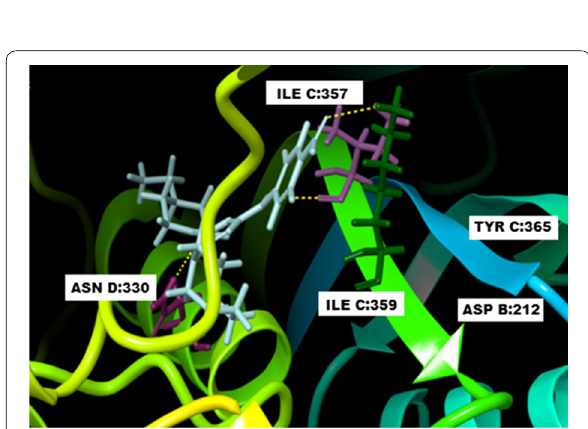
Fig. 3 3-D docked for binding of compound no 13 in the active site of